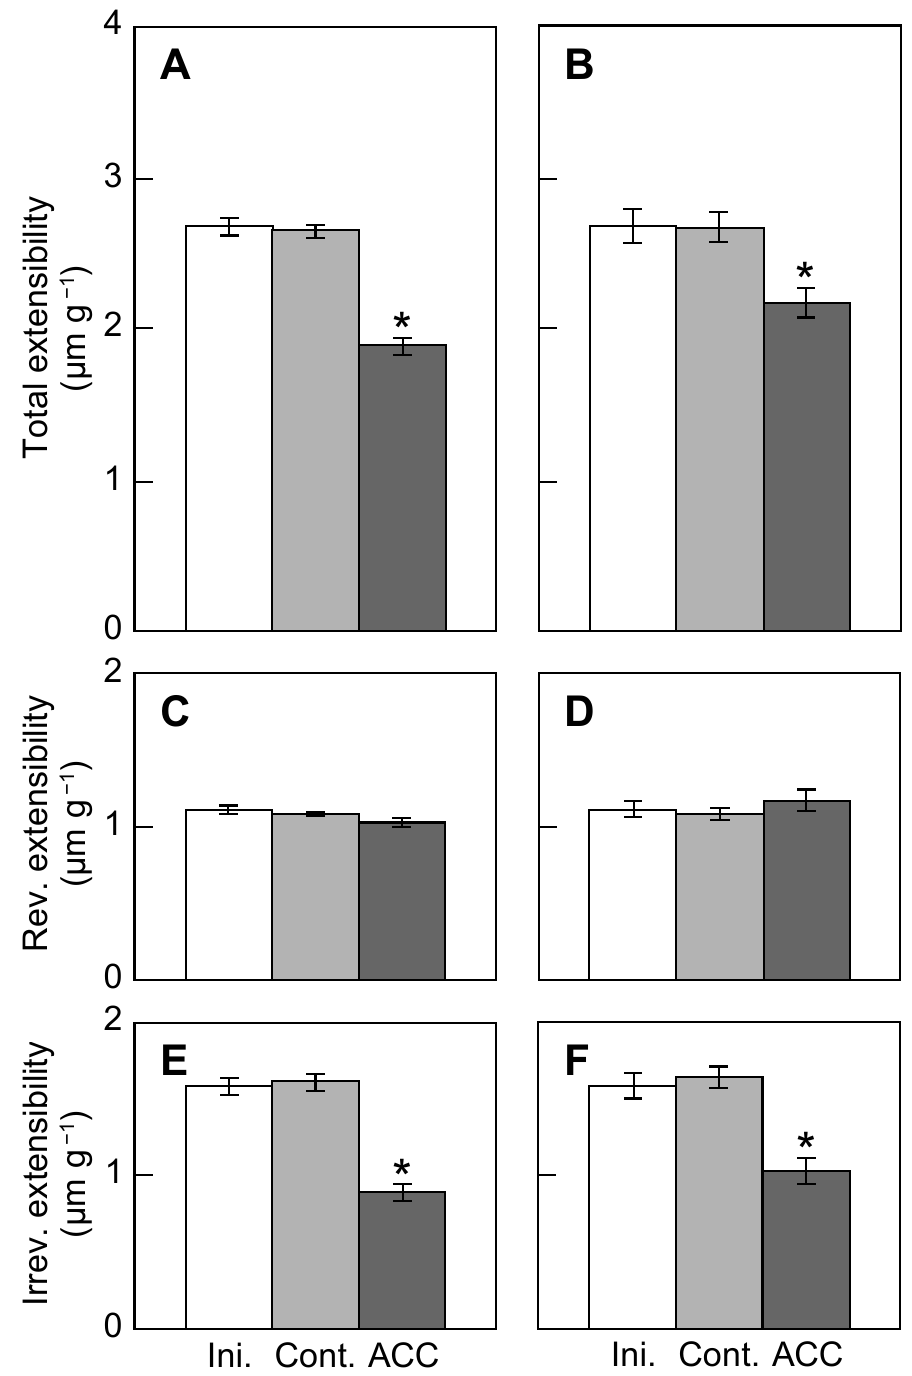
Figure 2. Total, reversible, and irreversible cell wall extensibility of ACC-treated azuki bean epicotyls. ACC treatment was carried out in accordance with the parameters shown in Figure 1. The material was extended two times consecutively using a tensile tester. Total extensibility ( A ) was determined by the slope of the load–extension curve at the first extension. Reversible extensibility ( C ) was determined by the slope of the second curve, and irreversible extensibility ( E ) was determined by the difference between the slopes of the first and second extensions. The total extensibility, reversible extensibility, and irreversible extensibility were normalized by multiplying the ratios of the cross-sectional area of epicotyls, wherein the area of the initial epicotyls was equal to one ( B , D , F ). Values are the means ± SE ( n = 30). * p < 0.05, mean with significant differences between control and ACC treatments.